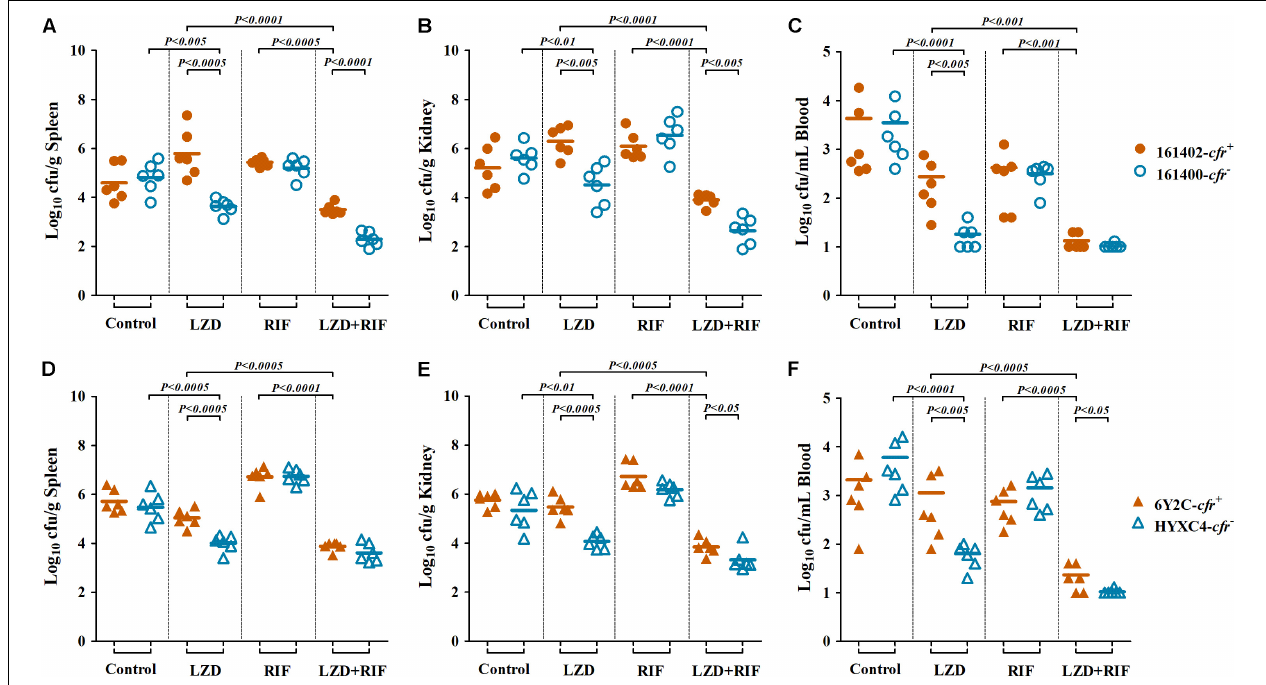
FIGURE 4 | MRSA densities in spleen (A,D) , kidney (B,E) , and blood (C,F) in the murine bacteremia model due to cfr -positive (161402 and 6Y2C) and -negative (161400 and HYXC4) MRSA strains with linezolid or rifampicin mono- and combination therapies (LZD at 100 mg/kg, RIF at 5 mg/kg, orally twice a day for 3 days, starting at 24 h post-infection). Each dot represents one mouse, and the horizontal lines indicate the means of observations from groups of six